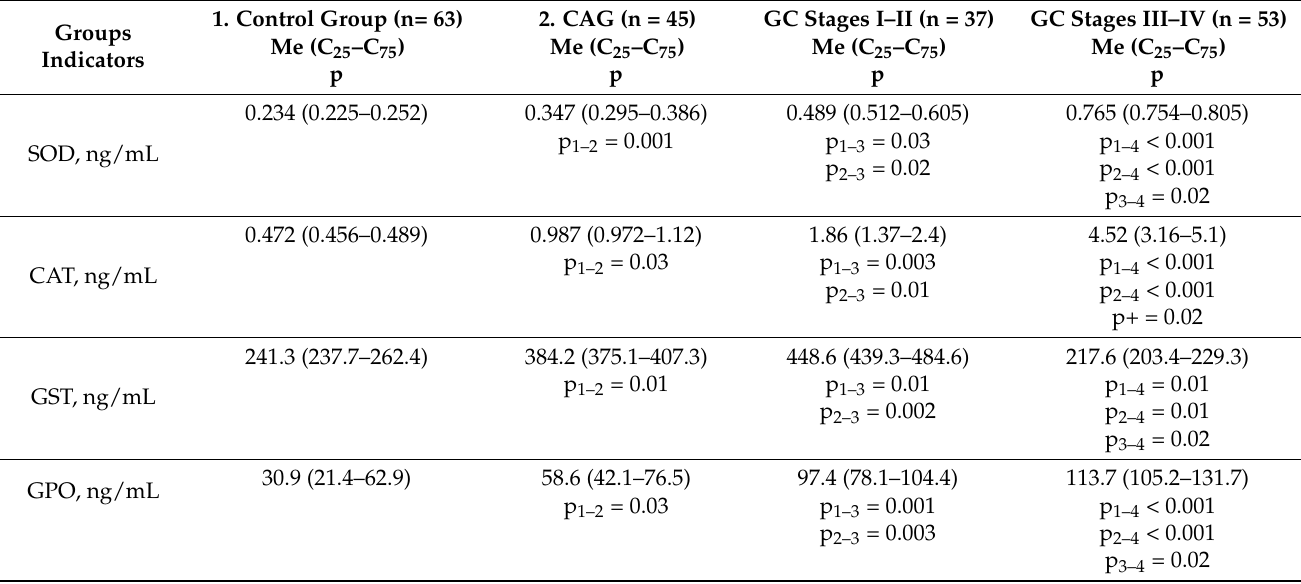
(Table 2). Enzymes of the glutathione link also showed their activity in different ways in the groups; there was an increase in the content of GST and GPO in patients with CAG and GC stages I–II, and an unbalanced activity in patients with GC stages III–IV in the form of a significant decrease in GST, and a slight increase in the concentration of GPO. Table 2. Indicators of antioxidant enzymes in the blood plasma in patients with atrophic gastritis and gastric